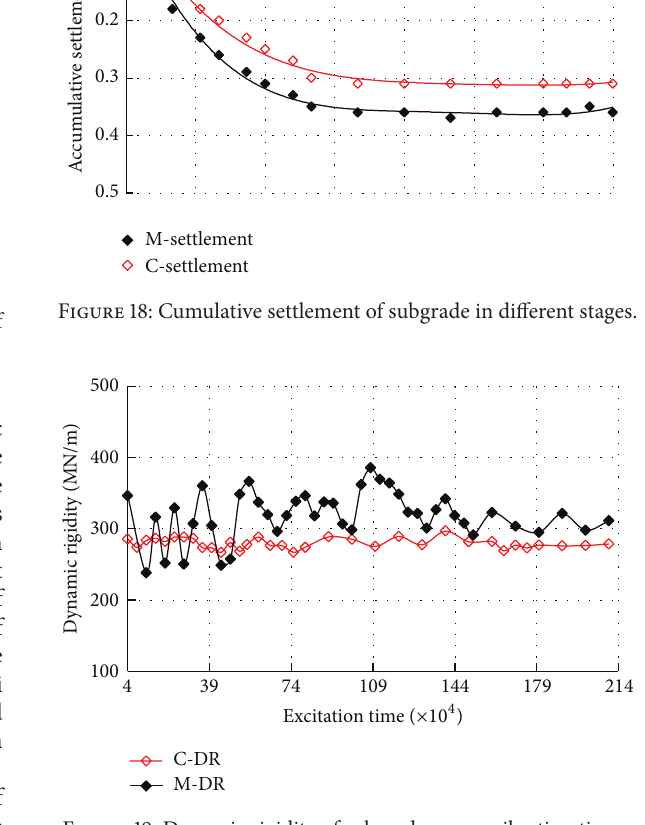
Figure 19: Dynamic rigidity of subgrade versus vibration